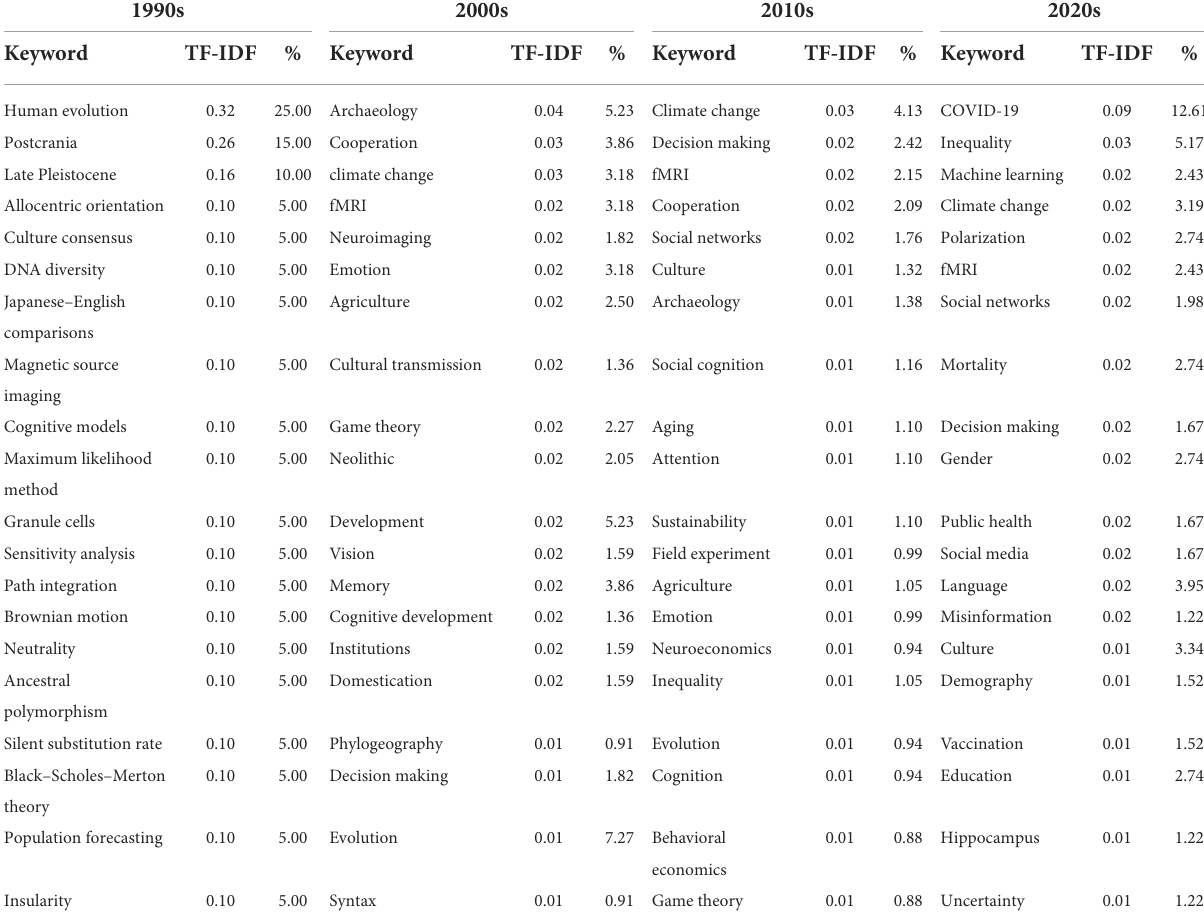
TABLE 6 Top 20 elite keywords in each era, and the proportion of publications that contain elite keywords.